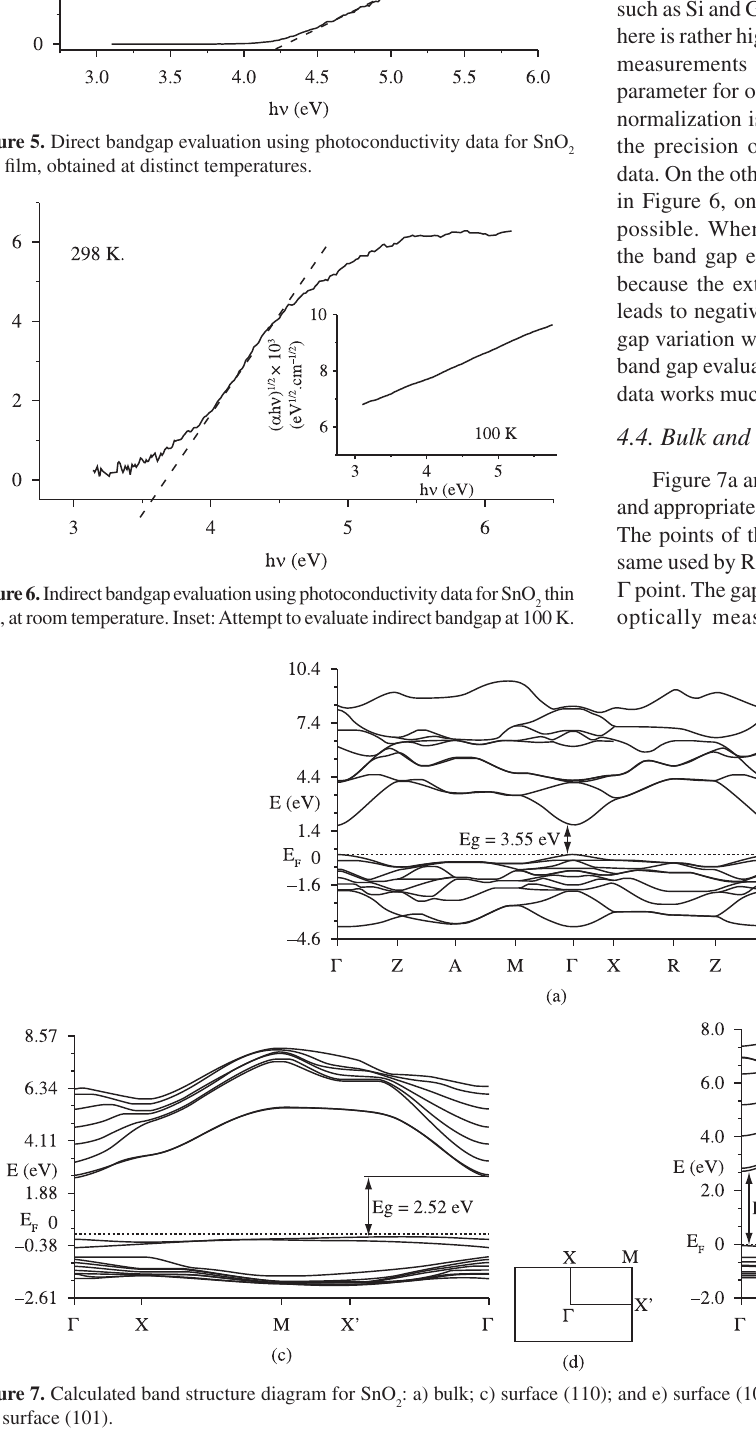
Figure 7. Calculated band structure diagram for SnO and surface